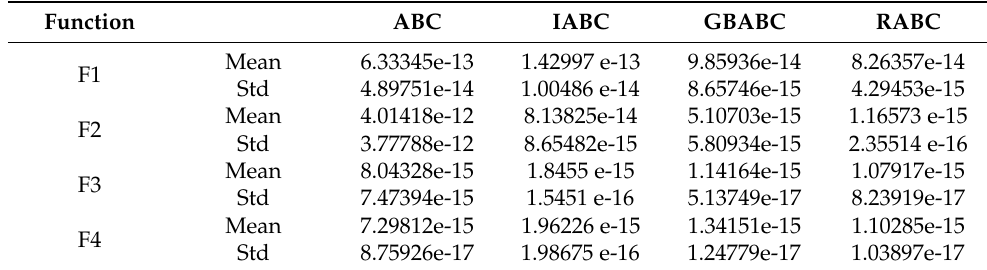
Table 2. Mean and std obtained by the ABC, IABC, GBABC, and RABC algorithms.